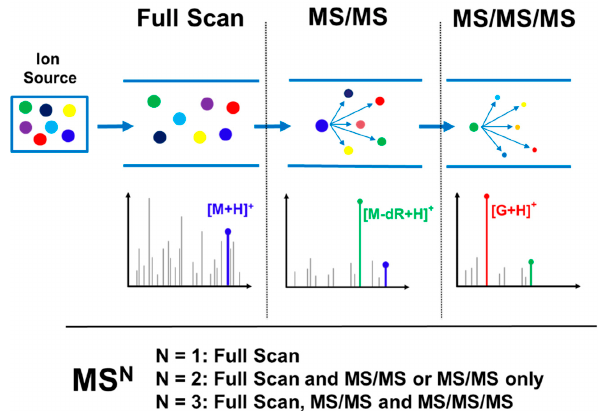
Figure 4. Illustration of different types of high resolution accurate mass (HRAM) DNA adductomic (MS n ) detection where N = 1 represents Full Scan, N = 2 represents Full Scan and MS/MS or MS/MS only, and N = 3 represents Full Scan, MS/MS, and MS/MS/MS. In this example, M is a nucleoside adduct with the general formula of M = X-G-dR where G is guanine, dR is the deoxyribose moiety, and X is the modification. In the Full Scan panel, the accurate mass of the DNA adduct ([M + H] + ) can be extracted to generate a chromatogram and provide molecular formula information (this step is common to both DDA and DIA approaches). In the second panel, the MS/MS signal can either be extracted to generate a chromatogram (as in the case of a DIA approach) or provide MS / MS spectral data for the adduct (as in the case of a DDA approach). Finally, in the third panel, the MS/MS/MS fragmentation data can be used to indicate presence of a DNA adduct as well as provide structural confirmation/information (this is the final step for the DDA approach, while it is done in a separate injection in a DIA approach, focusing on candidate adducts identified in the first analysis).